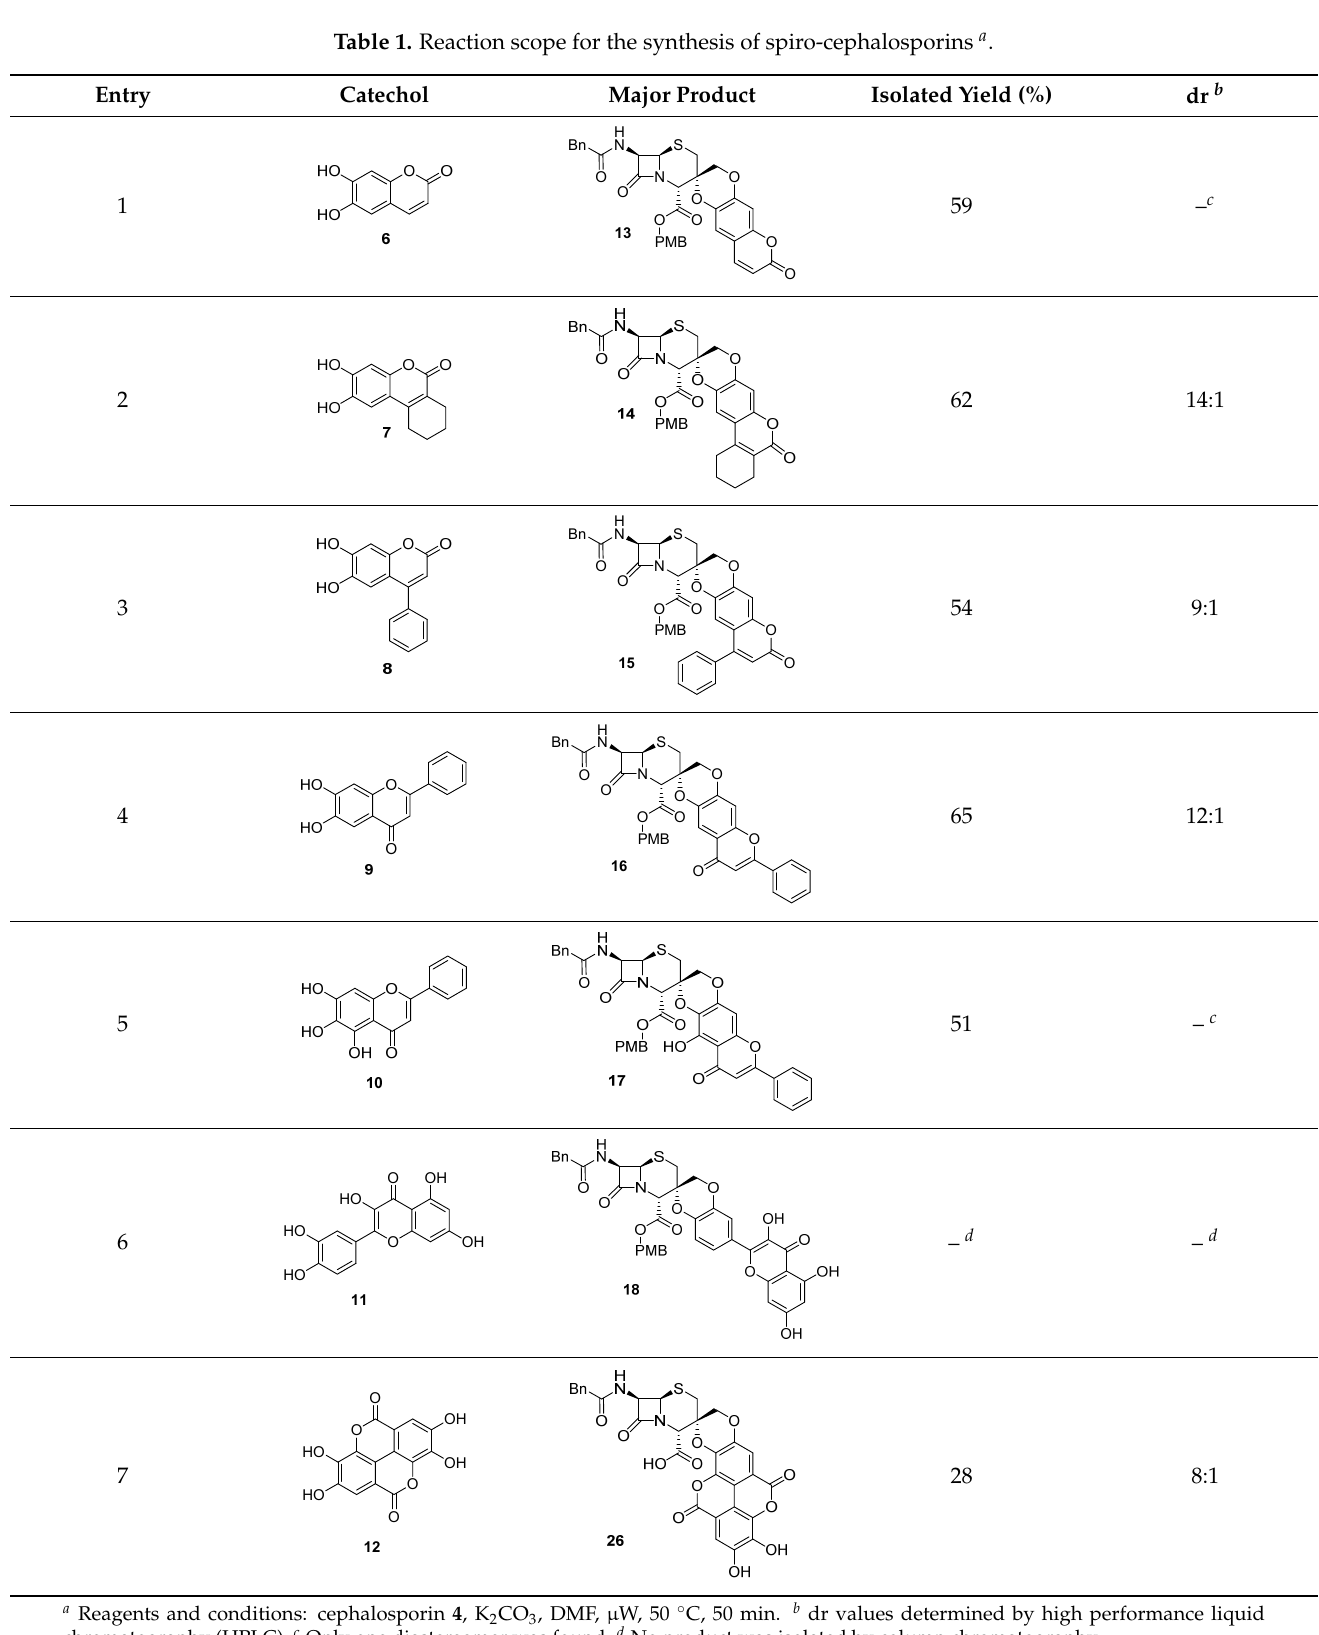
Table 2. PMB deprotection of